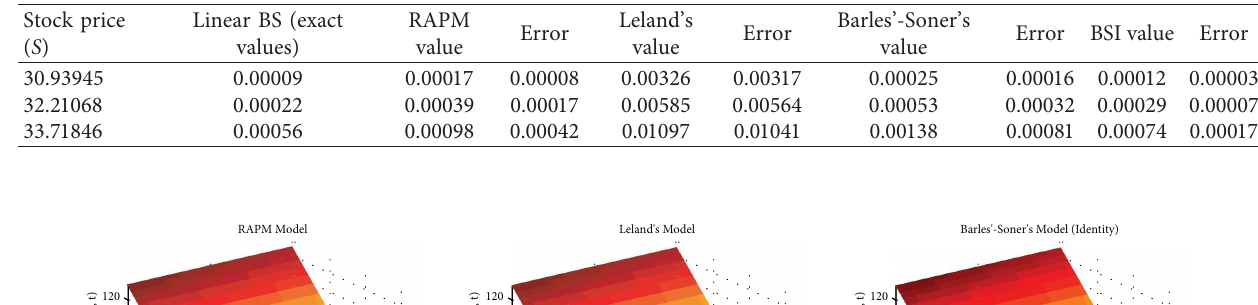
Table 1: Absolute errors of volatility models by differential Quadrature scheme at t � 0. Here, BS means the Black-Scholes model, and BSI means the Barles’-Soner’s